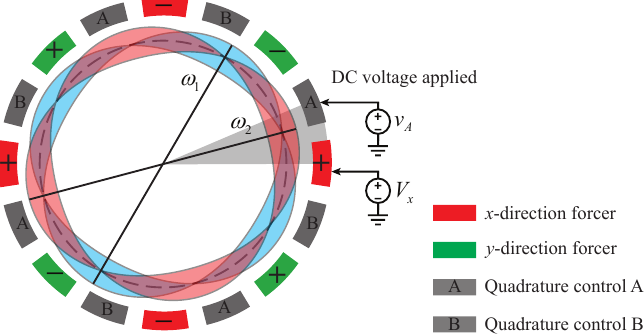
Figure 10. Configuration of the tuning electrodes for non-ideal micro-resonators.